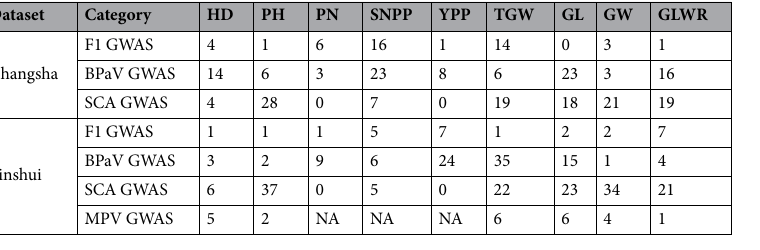
Table 1. Summary of QTLs found in